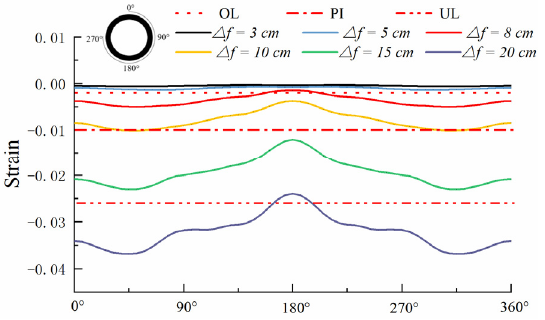
Figure 7. Axial strain distribution curves of the steel tube at peak strain sections under different fault displacements ( β = 60°; Stiff).